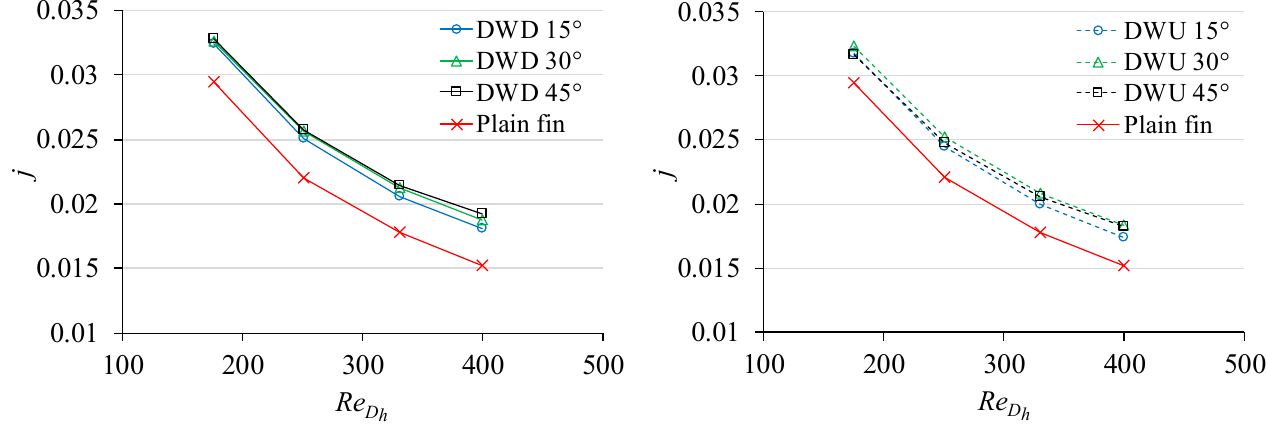
Figure 11. The effect of attack angle on the Colburn factor j for air-to-water FTHEX with delta-winglet downstream (DWD, solid lines) and delta-winglet upstream (DWU, dashed lines) configurations. Test conditions: T air,in = 22 °C, T water,in = 40 °C, w water,in = 0.76 m/s. The increase in heat transfer is often accompanied by an additional pressure drop.